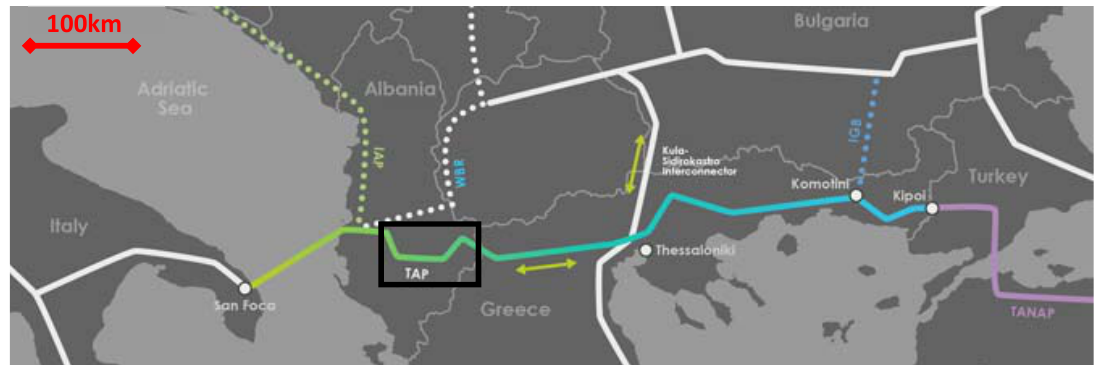
Figure 2. The schematic TAP route. The study area (shown with a black rectangle) spans approximately from 70 km to 136 km (KP70-KP136). (www.tap-ag.com).